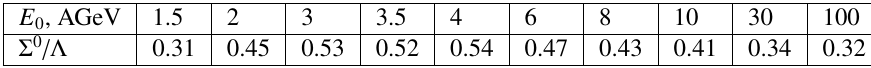
Table 2. Σ 0 /Λ ratio in C-C collision from UrQMD